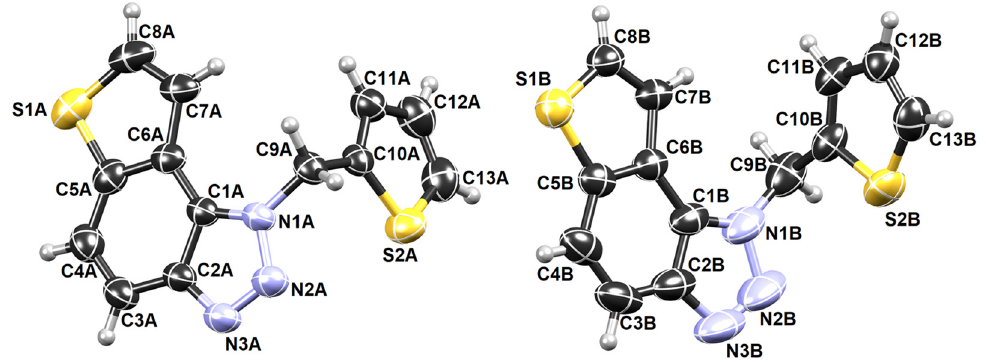
Figure 7. ORTEP-3 diagrams of two symmetry-independent molecules of 5 . Their conformations are enantiomeric-like (Figure 8a). The molecules stack in columns parallel to the axis a in an alternating fashion ( . . . ABAB . . . ) (Figure 8b). The stacks are laterally connected by weak C-H ··· N hydrogen bonds.